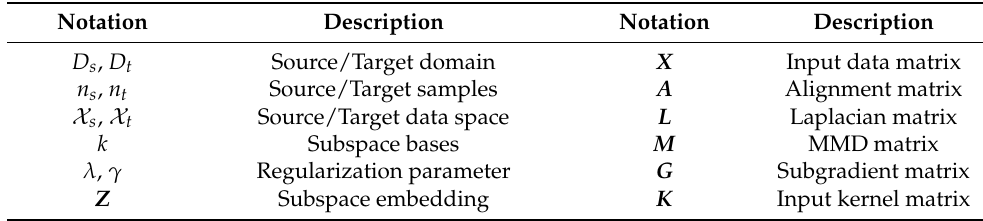
Table 1. Notations and